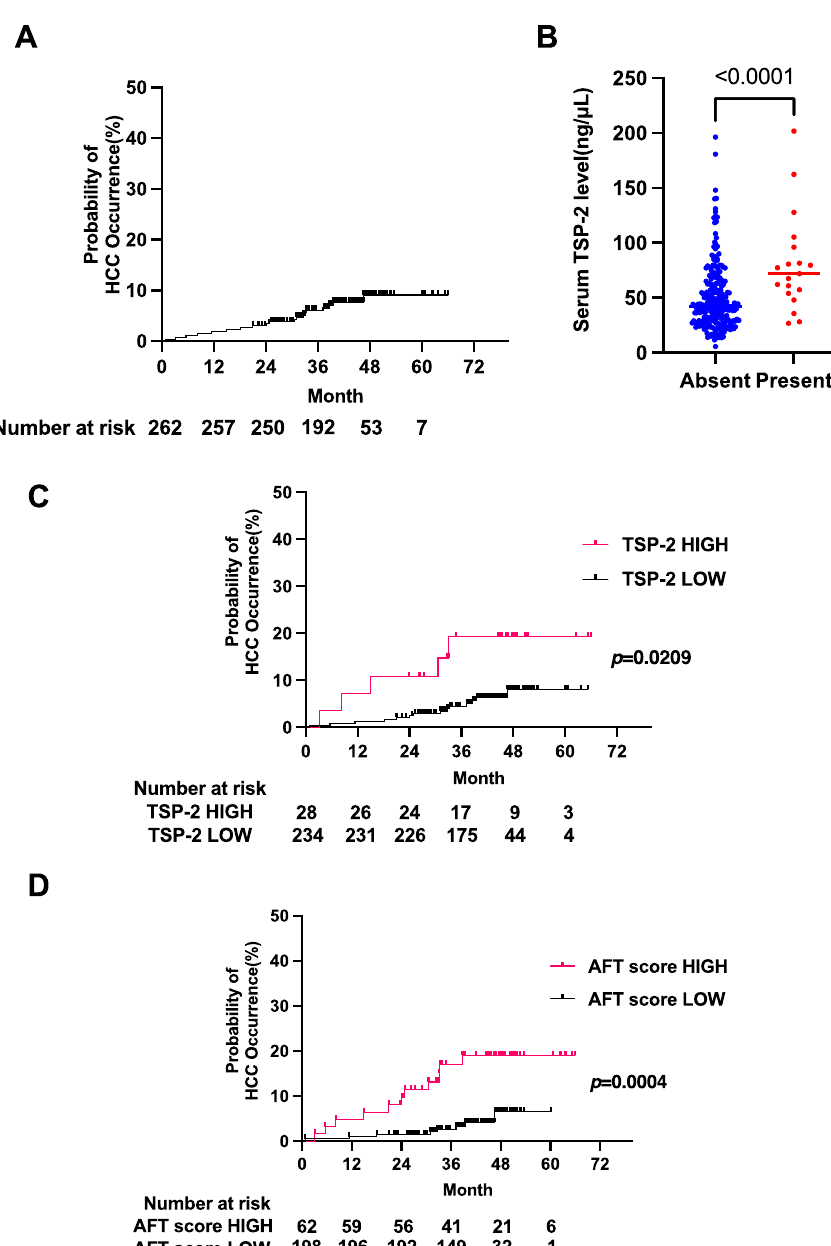
Figure 4. The TSP-2 and AFT scores stratified patients according to HCC risk in the validation cohort. ( A ) Kaplan–Meier curve for HCC occurrence. ( B ) Serum TSP-2 levels in the HCC+ group and HCC − group. ( C ) Kaplan–Meier curves for the occurrence of HCC in patients stratified by serum TSP-2 levels. ( D ) Kaplan–Meier curves for the occurrence of HCC in patients stratified by the AFT